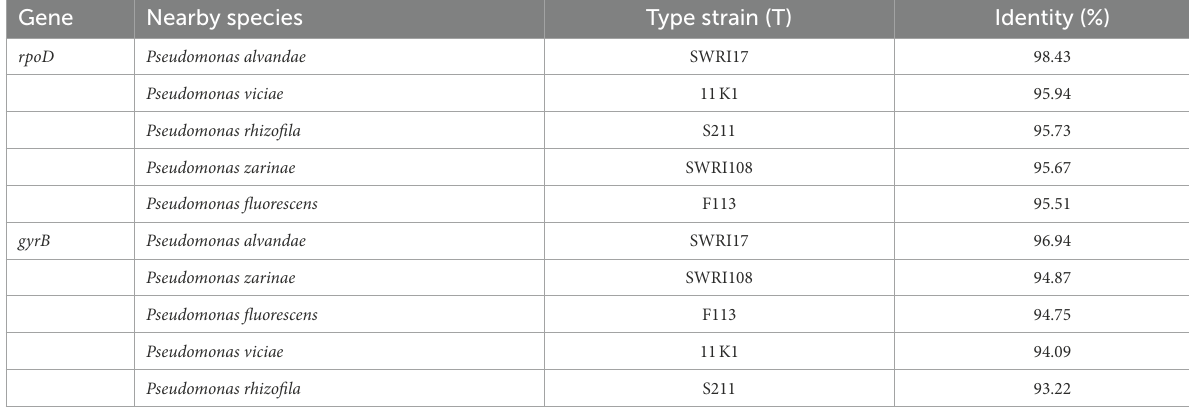
TABLE 6B Similarity of the gyrB and rpoD genes of the taxa with valid names and SAICEU22 T .